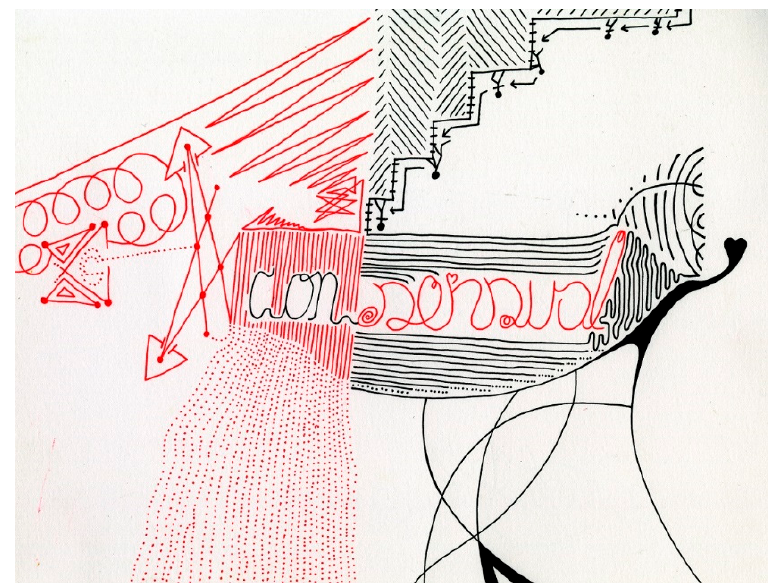
Figure A2. “Con-sensual”. Juxtaposition of black/red, curved/straight, patterns/negative space. Red and black pen, white paper.